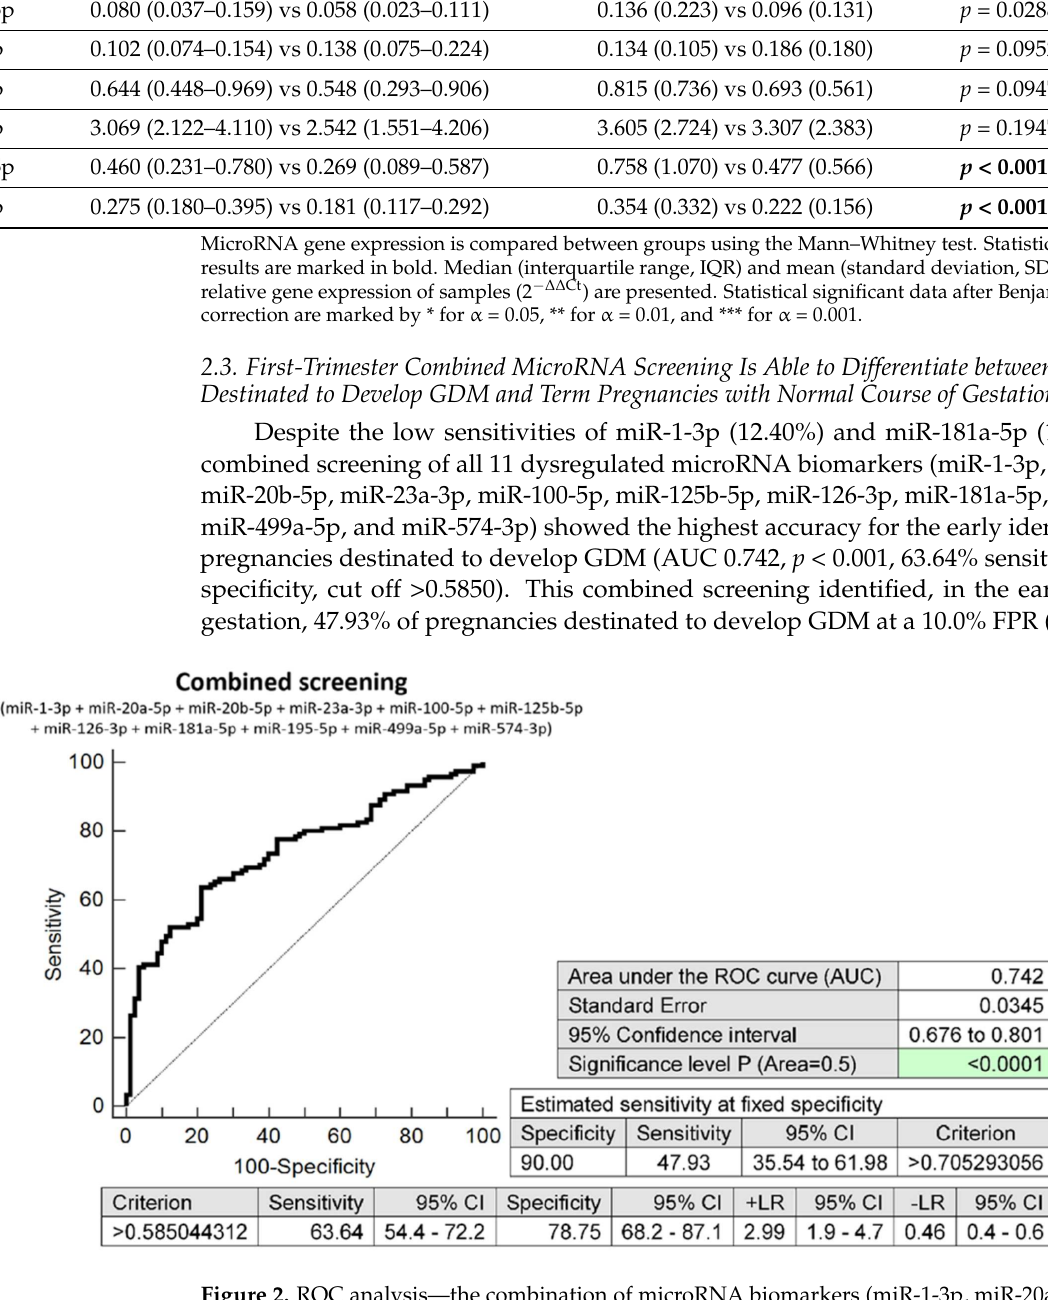
Figure 2. ROC analysis—the combination of microRNA biomarkers (miR-1-3p, miR-20a-5p, miR-20b- 5p, miR-23a-3p, miR-100-5p, miR-125b-5p, miR-126-3p, miR-181a-5p, miR-195-5p, miR-499a-5p, and miR-574-3p). A total of 47.93% pregnancies destinated to develop GDM had an aberrant microRNA expression profile in the whole peripheral venous blood during the first trimester of gestation at a 10.0% FPR. This represents 58 out of 121 pregnancies correctly predicted to develop GDM and 8 out of 80 normal pregnancies predicted false positively to develop